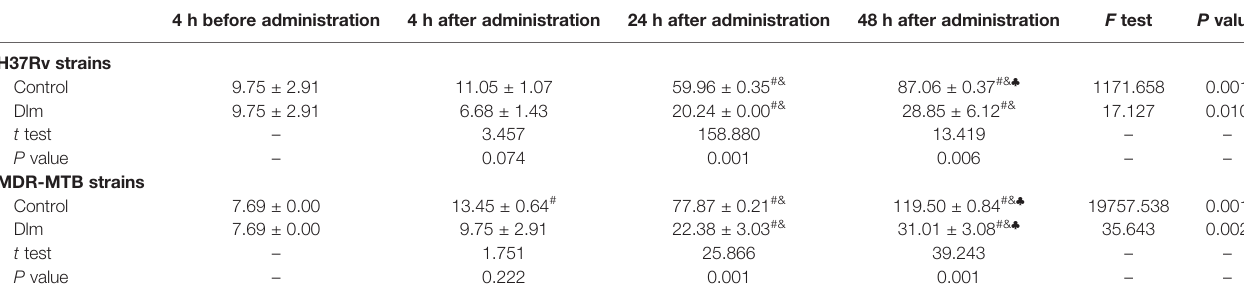
TABLE 4 | The level of IL-6 in the culture supernatant of macrophages infected by MDR-MTB after Dlm was administered (pg/ml, (cid:1) x ± s